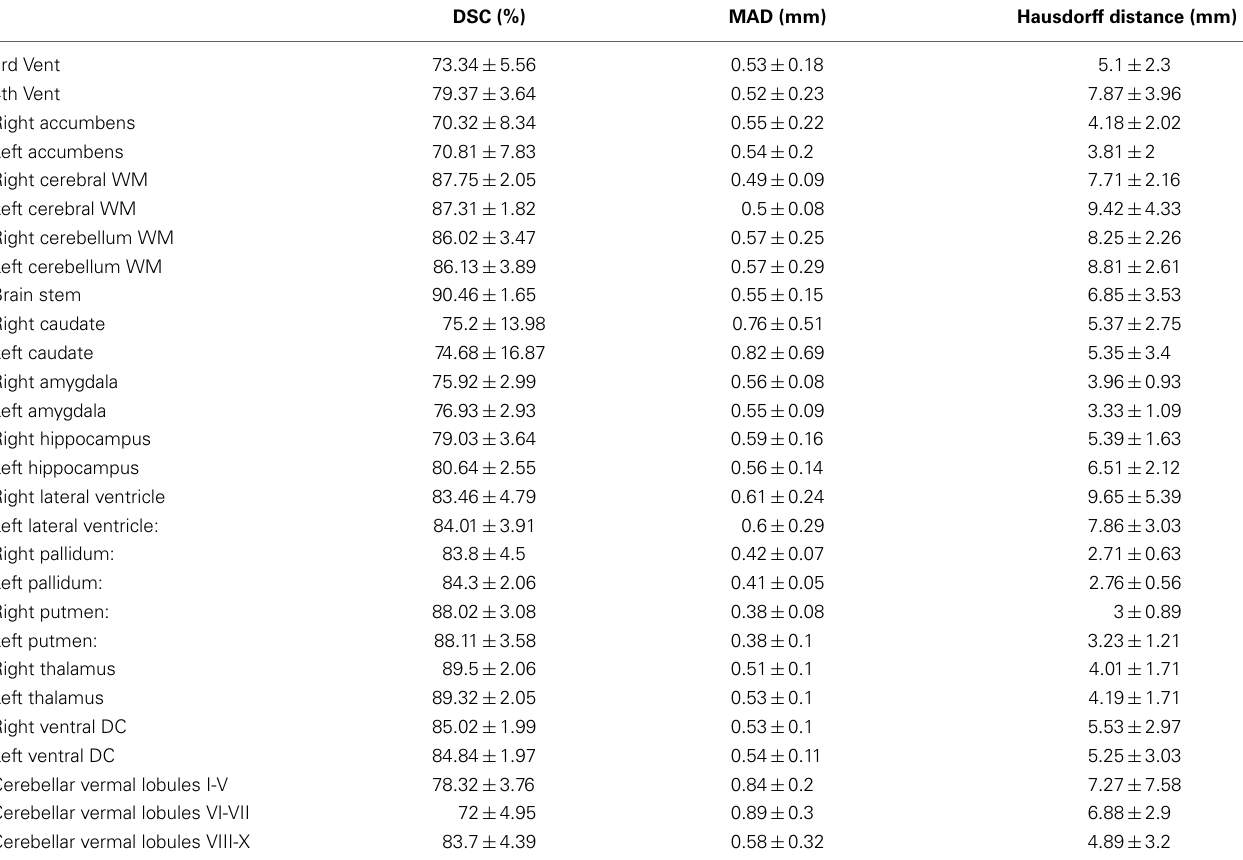
Table 1 | Mean Dice Similarity Coefficient (DSC), symmetric Mean Absolute Distance (MAD), and symmetric Hausdorff distance for subcortical